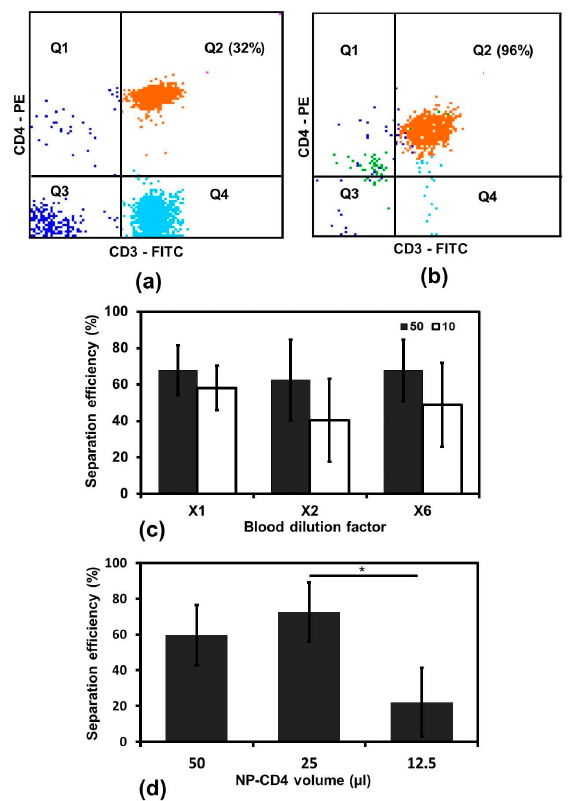
Figure 2. CD4 + T cell separation from blood. Representative images of FACS analysis data showing the percentage of CD4 + T cell population (Q2, orange) ( a ) before and ( b ) after separation from blood samples using NP-CD4. ( c ) The separation efficiency (SE) from 50 µL (dark black bar) and 10 µL (white bar) of undiluted (X1), 2-fold diluted (X2) and 6-fold diluted (X6) blood samples ( n = 5); ( d ) SE from 50 µL undiluted blood using 50, 25, and 12.5 µL NP-CD4 ( n = 3). p values were generated using Student’s t -test (* p < 0.05). The error bars represent the standard deviation of measurements.